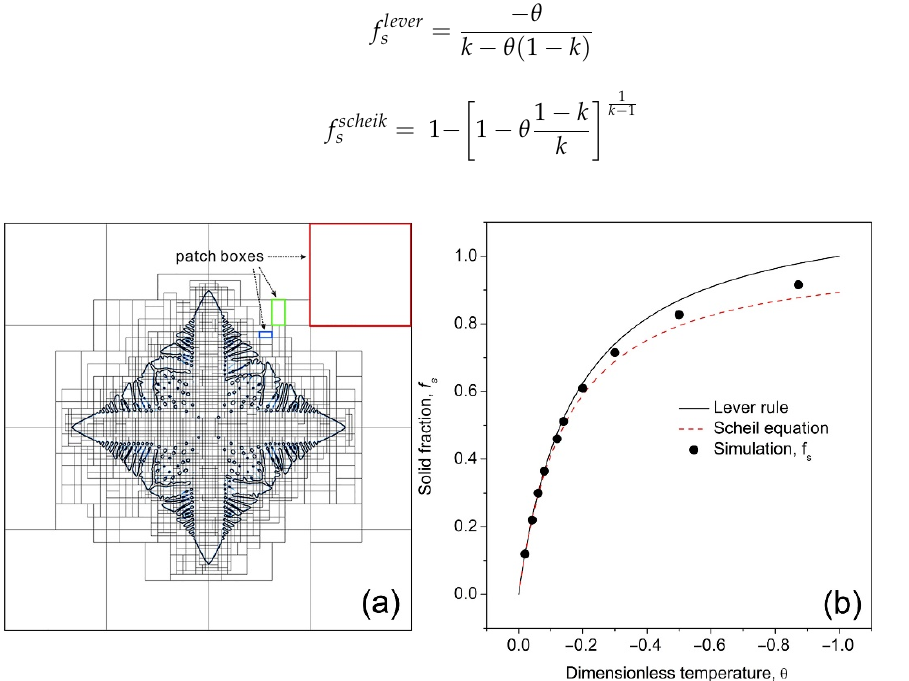
Figure 3. ( a ) An example of the adaptive mesh structure on the x-y plane generated using the block-structured adaptive mesh refinement algorithm. ( b ) The calculated volume fraction of solid, f s using the 3D phase field model and comparison with those calculated using the Lever rule and Scheil equation.